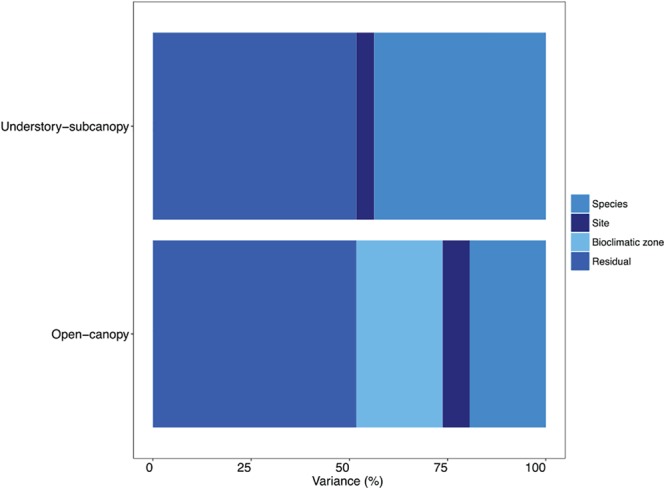
Bar graph showing in percentages the proportional contribution of species, site, bioclimatic zone and residual to variance in maximum stomatal conductance (gsmax) in the understory-subcanopy and open-canopy habitats (see Supplementary Table S10 for percentage breakdown).